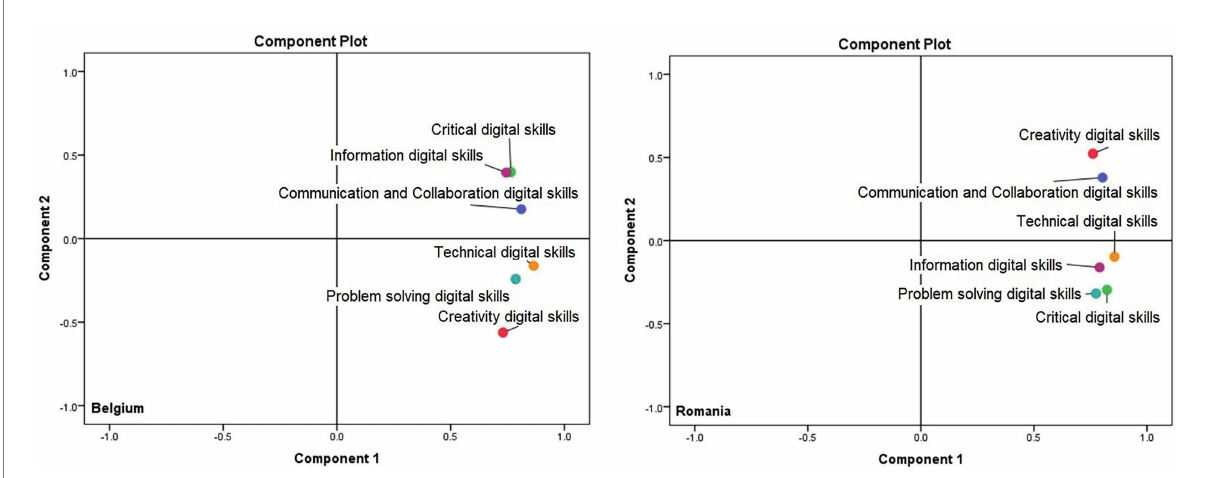
FIGURE 3 Relationships among Digital Skills in Belgium and Romania. Source: authors’ calculations based on the Stata statistical analysis